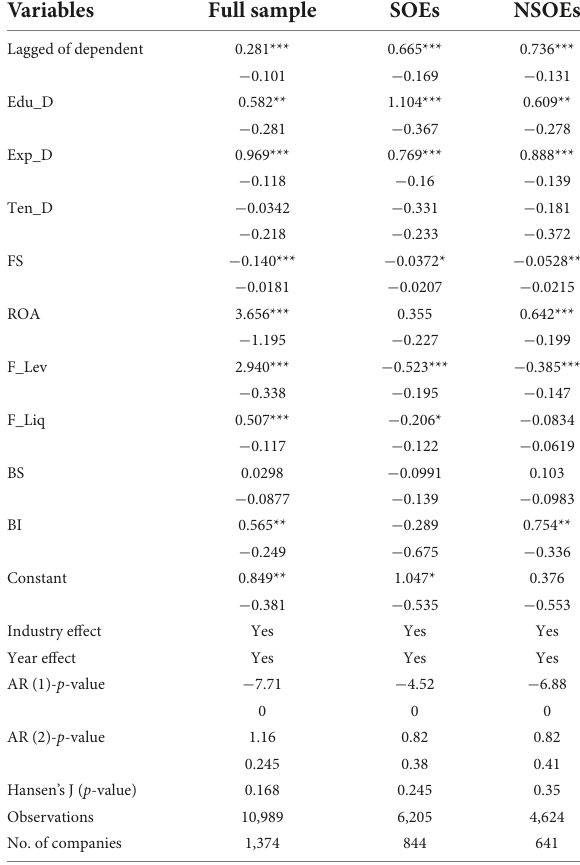
TABLE 7 Endogeneity test using GMM